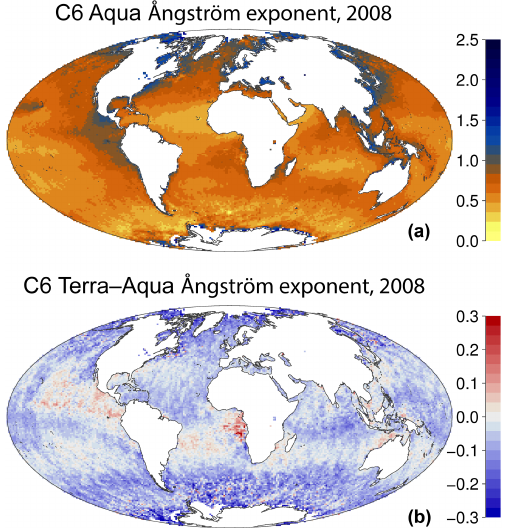
Figure 4. Gridded (0.625 ◦ × 0.5 ◦ ) global mean AE (at 0.55/0.86µm) for 2008 derived from MYD04 (a) and the dif- ference between MOD04 and MYD04 (b) .